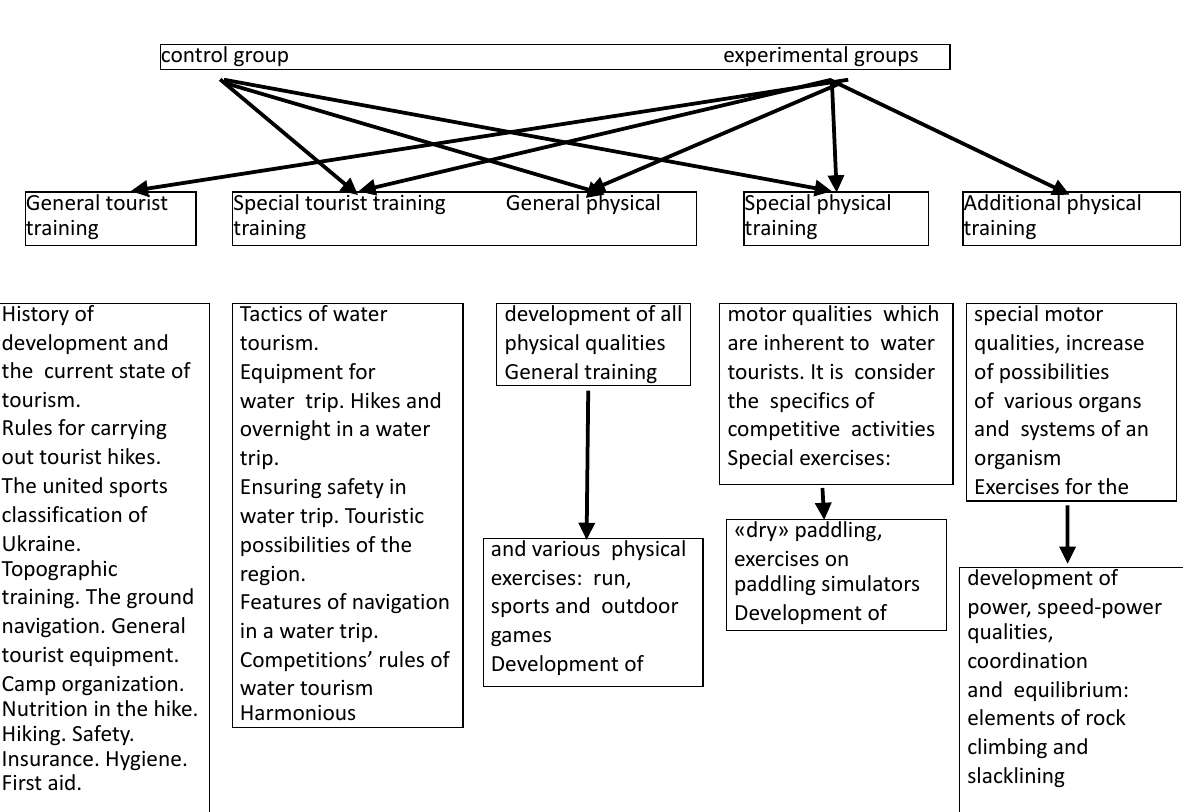
Fig. 1. Means of various training types of control and experimental groups’ tourists at the stage of preliminary basic training in the preparatory